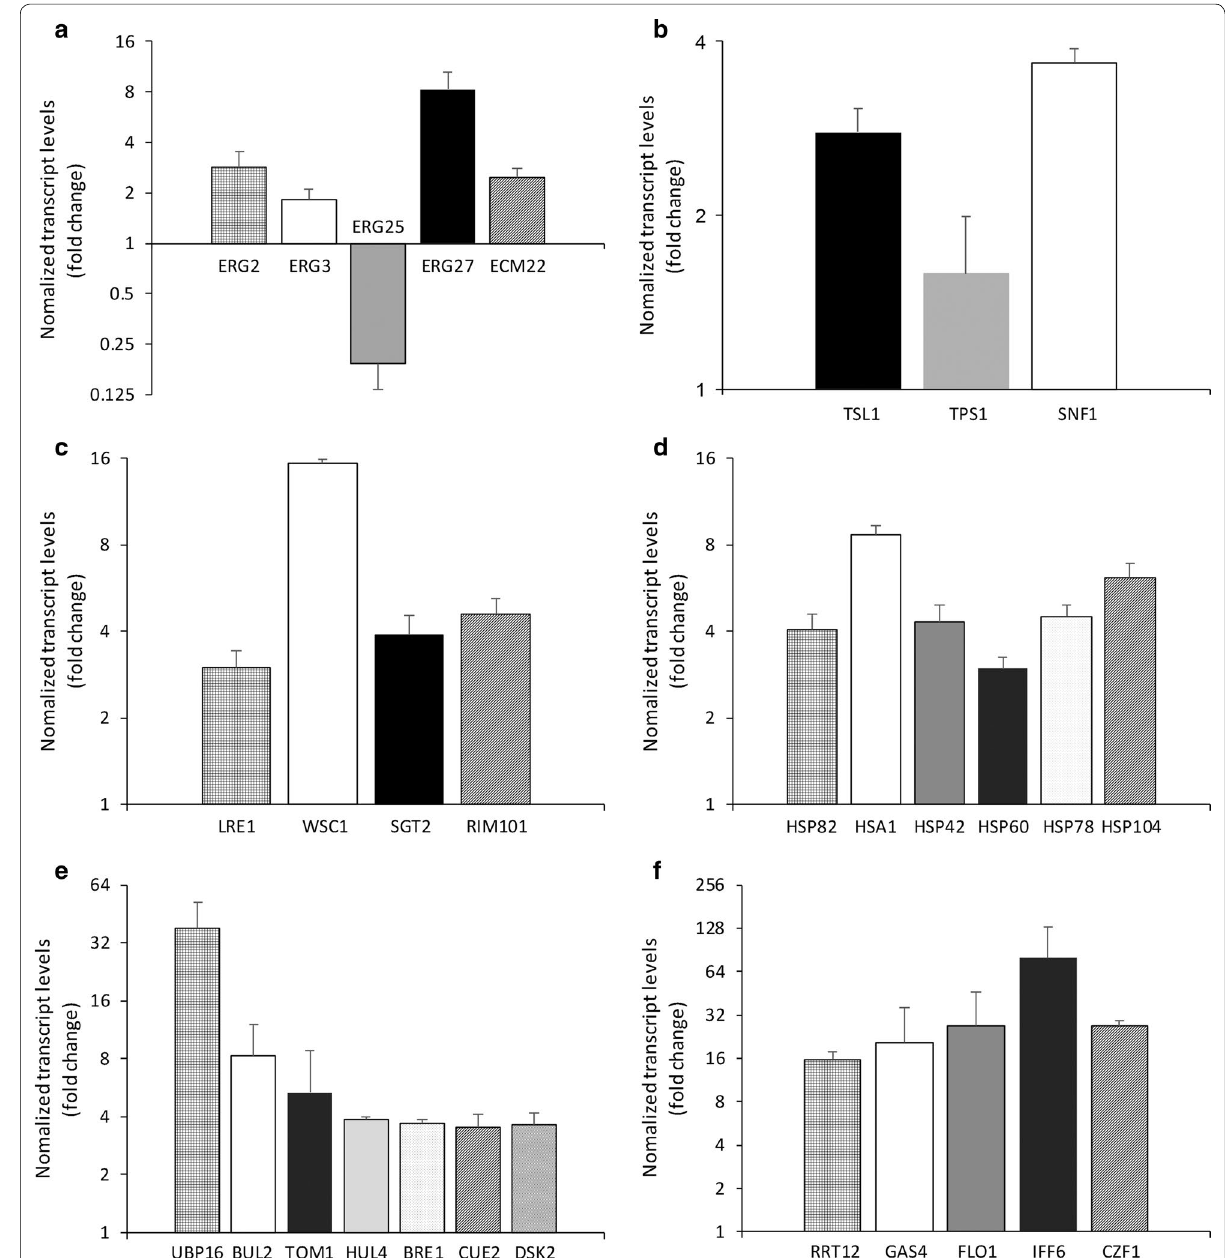
Fig. 4 Normalized transcript levels for selected I. orientalis DEGs determined by RT-qPCR. Transcript levels (fold changes) for DEGs are shown relative to levels in I. orientalis before ethanol stress. Bars represent mean values S.D. for three biological replicates. DEGs are grouped by function. a DEGs ± associated with the ergosterol pathway. b DEGs associated with the trehalose pathway. c DEGs associated with responses to stress and stimulus. d DEGs associated with heat shock proteins (HSPs). e DEGs associated with the ubiquitin–proteasome proteolytic pathway. f DEGs associated with meiosis, sporulation, and ascospore cell wall